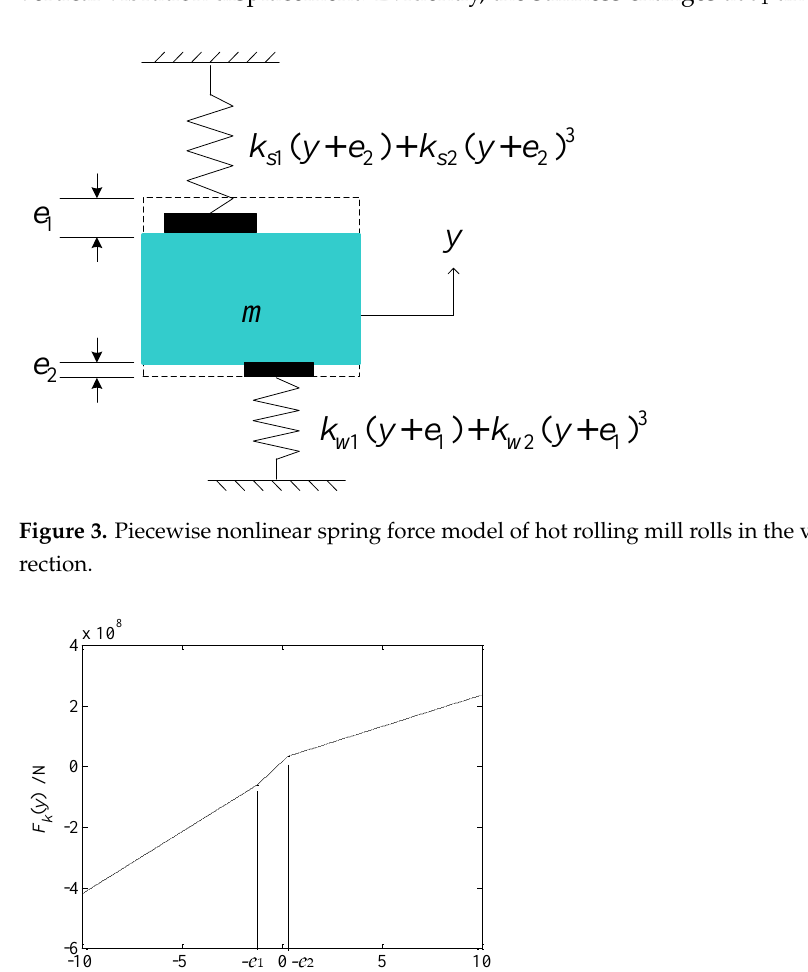
Figure 3. Piecewise nonlinear spring force model of hot rolling mill rolls in the vertical vibration direction.